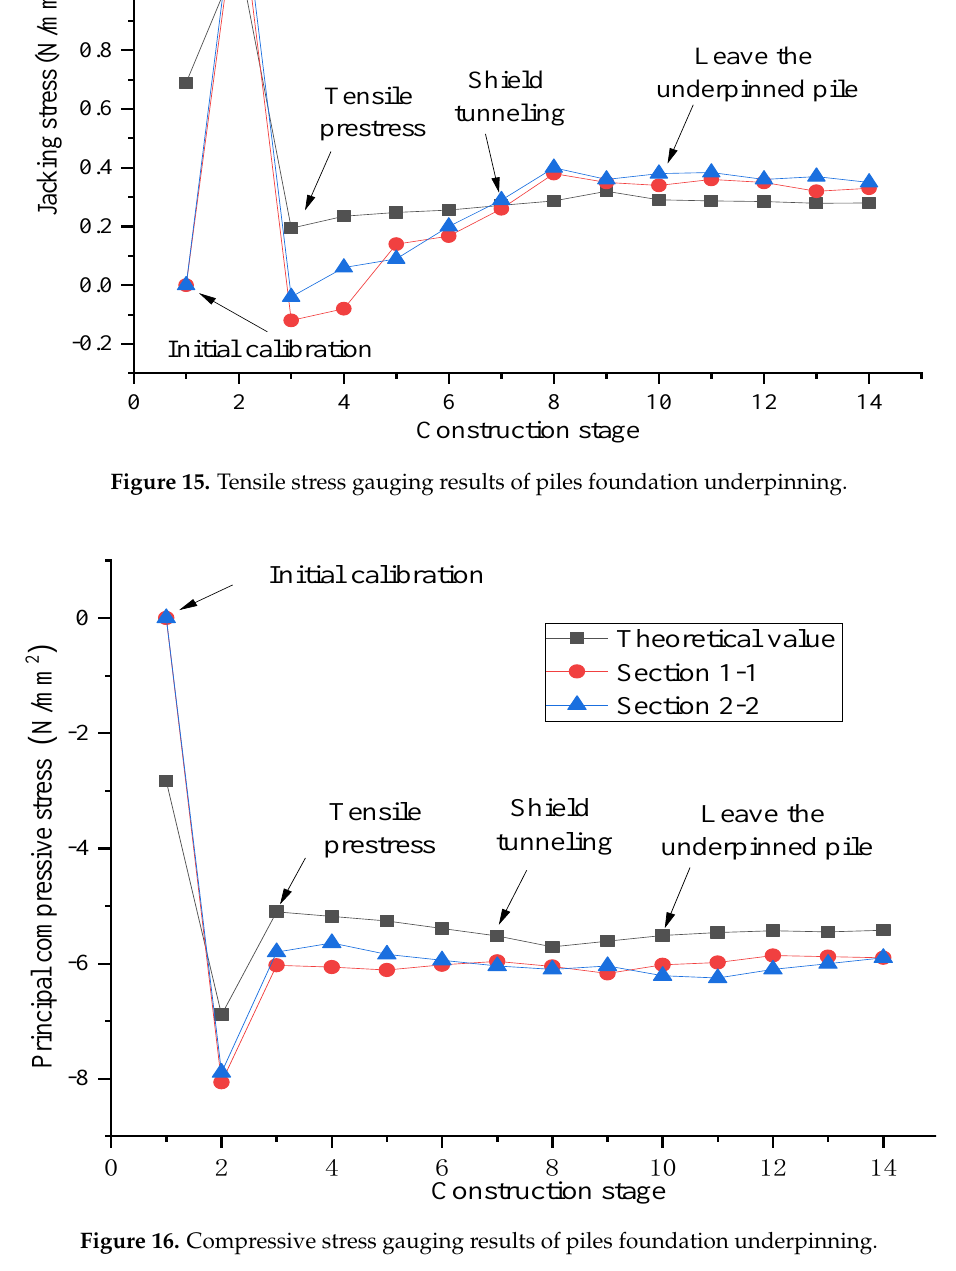
Figure 16. Compressive stress gauging results of piles foundation underpinning. Comparison of monitoring data of four sections clearly indicates that the piles